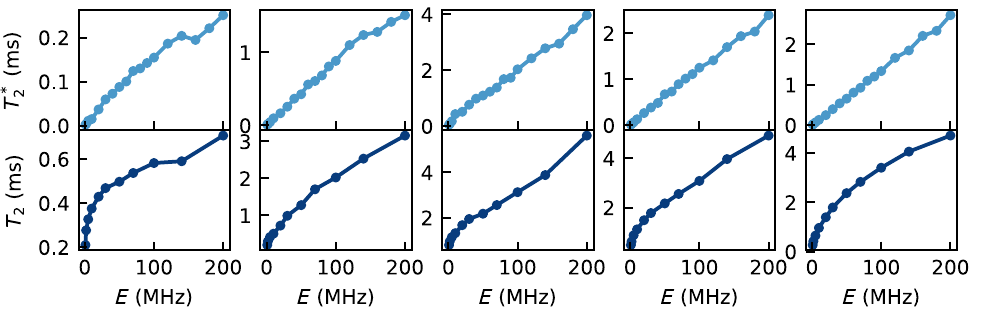
FIG. 17. Coherence time of the kh -V C V Si diva- cancy for Ramsey (top) and Hahn-echo (bottom) experiments as a function of the transverse ZFS E for five random nuclear spin configurations without strongly coupled nuclear